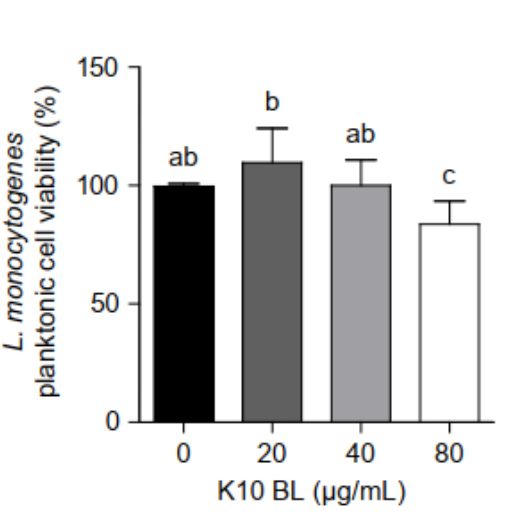
Figure 3. The viability of planktonic L. monocytogenes in the presence or absence of P. acidilactici BLs. Planktonic L. monocytogenes was incubated with K10 BL ( A ) or HW01 BL ( B ) (0, 20, 40, and 80 µ g/mL) at 37 ◦ C for 24 h. After incubation, L. monocytogenes was enumerated by plating samples on BHI agar. The results are represented as the means ± standard deviations from three independent experiments ( p < 0.05). Significant differences between treatment with K10 BL or HW01 BL are expressed with different letters (a-d).